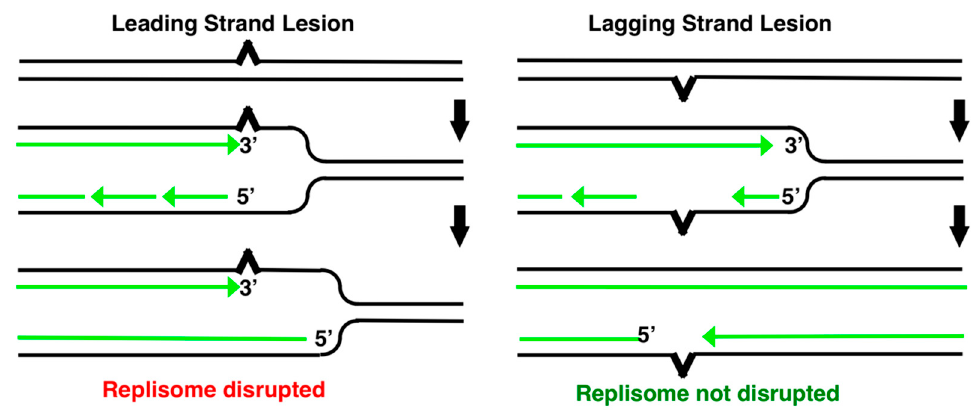
Figure 2. Substrates generated during replication on UV-damaged templates. Based upon our current understanding, lesions in the leading-strand template disrupt replisome progression. In contrast, lesions in the lagging-strand template produce gaps but do not disrupt replication.